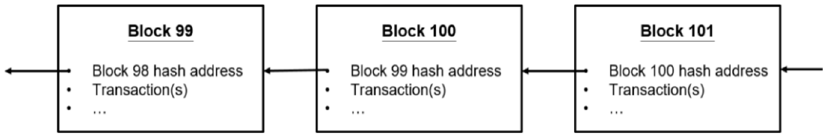
Figure 1. Link between the hash value and the